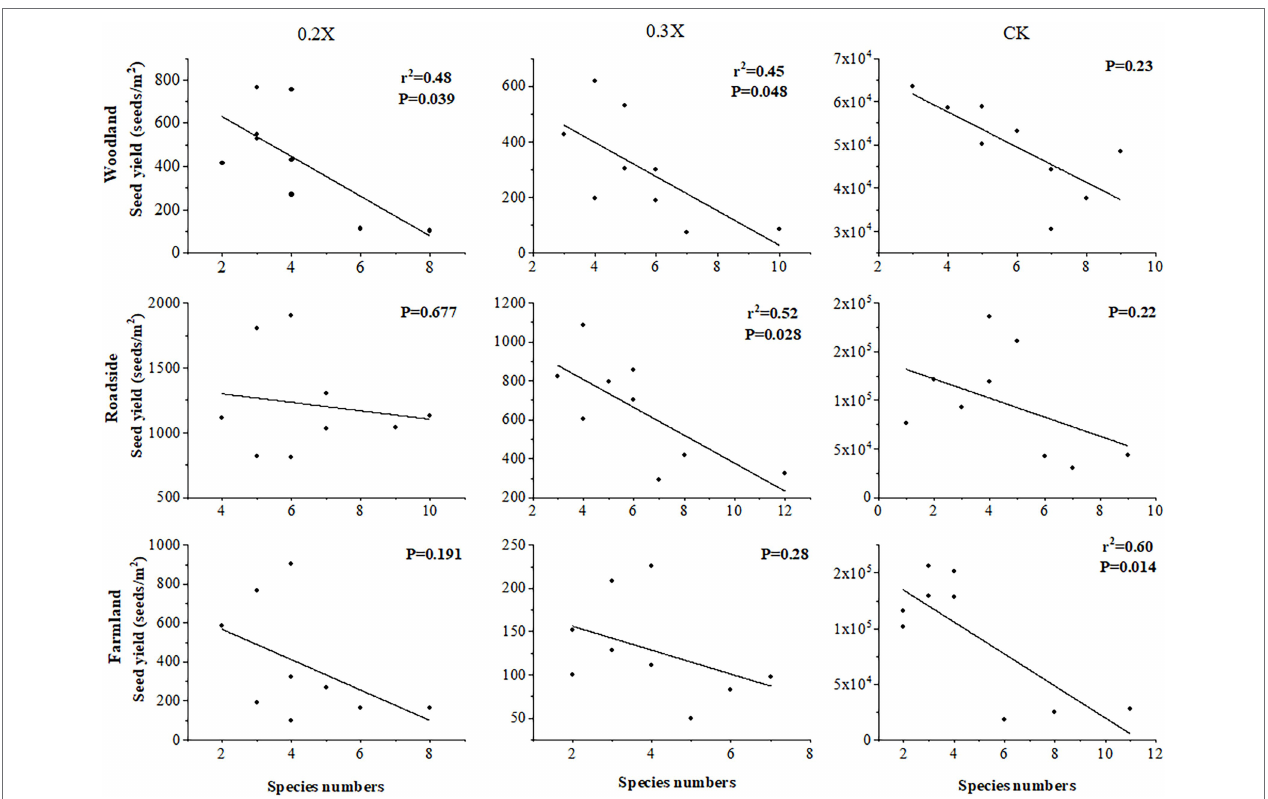
FIGURE 5 | Correlation analysis of native species richness and Ambrosia artemisiifolia seed yield. CK, control group, and 0.2X, 0.3X represent different doses of